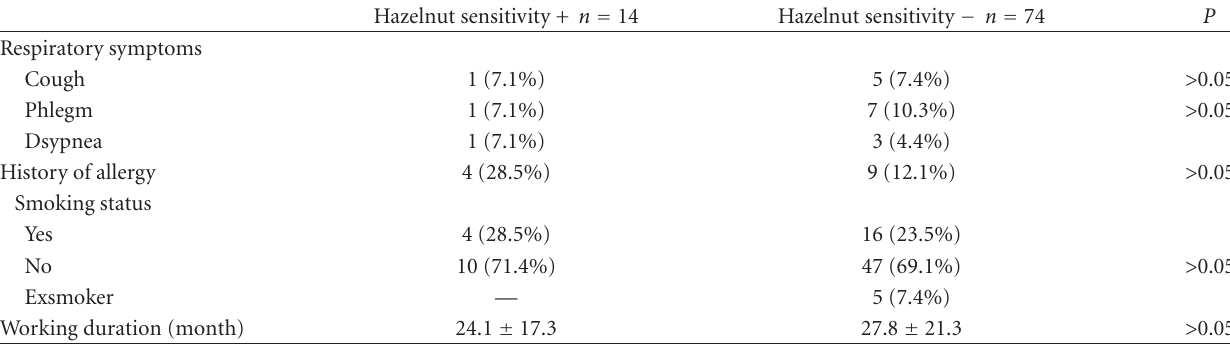
Table 3: The comparison of cases with and without specific IgE against hazelnut allergens regarding respiratory symptoms, history of allergy, and smoking status.